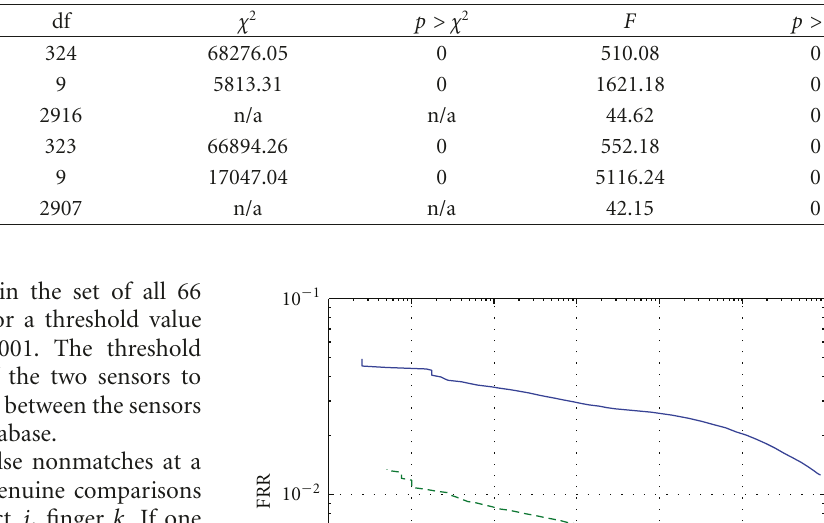
Table 2: Results for the Kruskal-Wallis test and analysis of variance (ANOVA) test for the optical and capacitive sensors. The factors that were taken into account were the subject index and the finger index. Tests were performed on the balanced database.